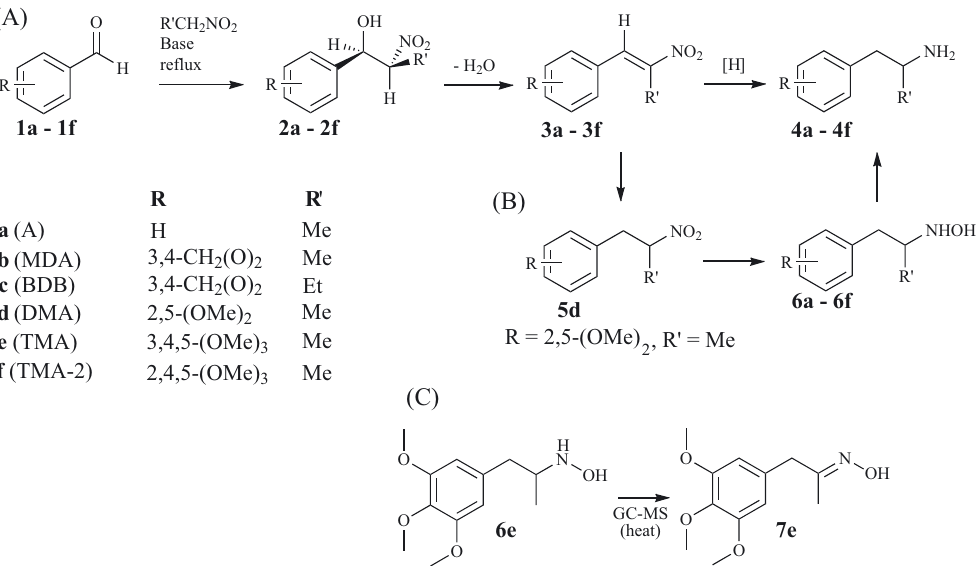
Figure 1. (A) Henry reaction: the synthesis of ( E )-nitrostyrene derivatives 3a-3f was based on the use of appropriately substituted benzaldehyde starting materials 1a-1f . C-C bond formation was base catalysed in order to facilitate conversion to nitroalcohol intermediates 2a-2f (not isolated), followed by proton abstraction and elimination of water. The desired phenylalkylamines 4a-4f were prepared by reduction of their nitroalkene precursors using several different reducing agents. Compound abbreviations: A: amphetamine; MDA: 3,4-methylene- dioxyamphetamine; BDB: 1-(3’,4’-methylenedioxyphenyl)butan-2-amine; DMA: 2,5-dimethoxyamphetamine; TMA: 3,4,5-trimethoxyam- phetamine; TMA-2: 2,4,5-trimethoxyamphetamine. ( B ) Incomplete reduction to the nitroalkane ( 5d ) was observed after the reduction of CN. ( C ) Representative example of a heat-induced disproportionation of hydroxylamine side products during GC-MS ( 3d ) with NaBH 3